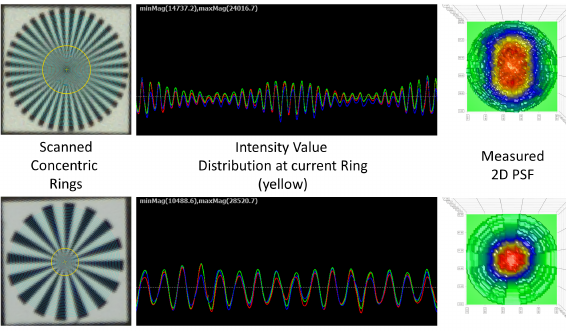
Figure 9. (top) Drone image with dominant motion smear, (bottom) drone image without dominant motion